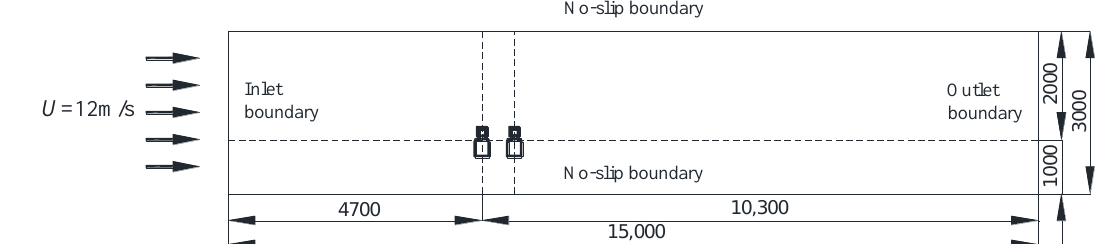
Figure 27. Computational domain and boundary conditions (units: mm).